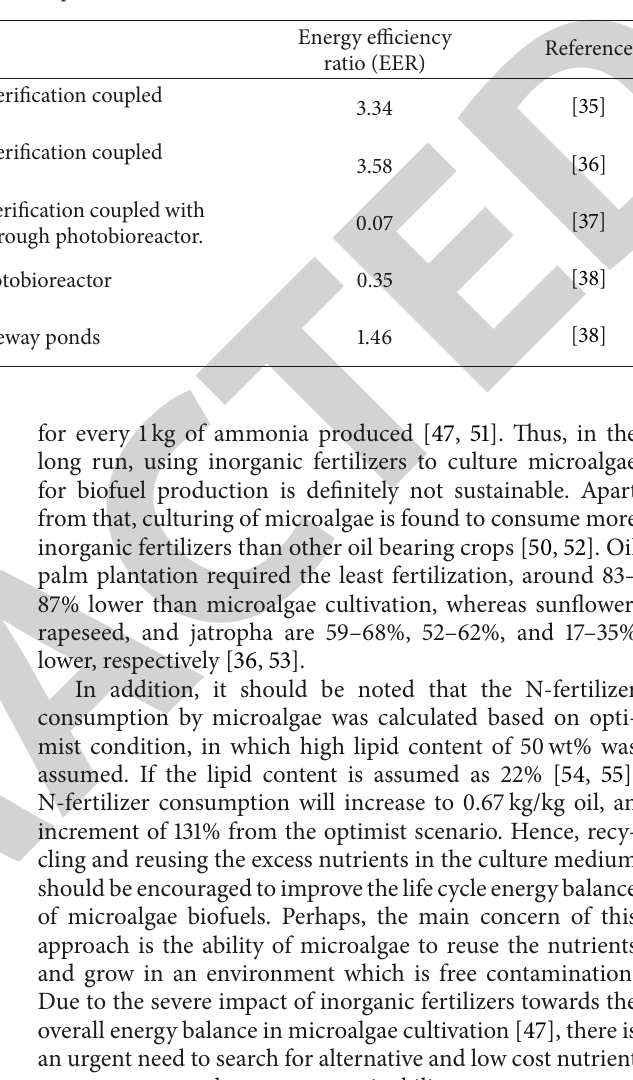
Table 1: Energy Efficiency Ratio for biofuels produced from different